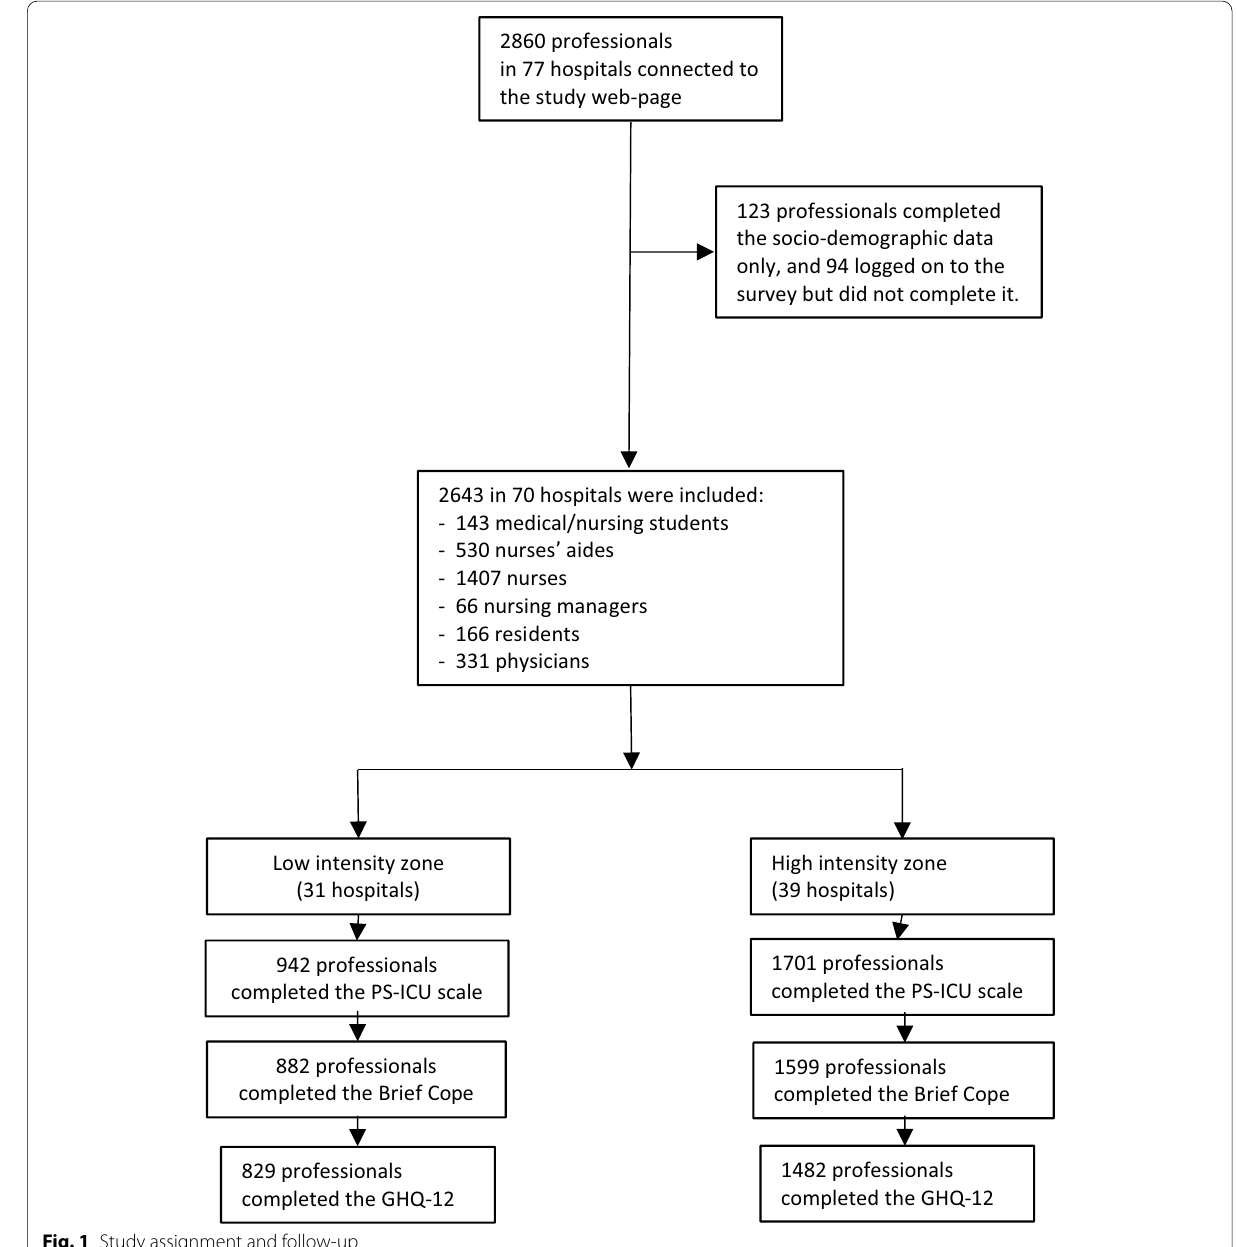
(Fig. 2). Among the six specific stress dimensions meas- ured by the stress scale, the effect of the epidemic inten- sity on mental health was mainly driven by dimension 2 (patient- and family-related emotional load, b CI [0.03, 0.22]) and dimension 6 (care provided in sub- optimal or conflictual conditions, B 0.18]) (Additional file 1: Appendix Figs. S3 to